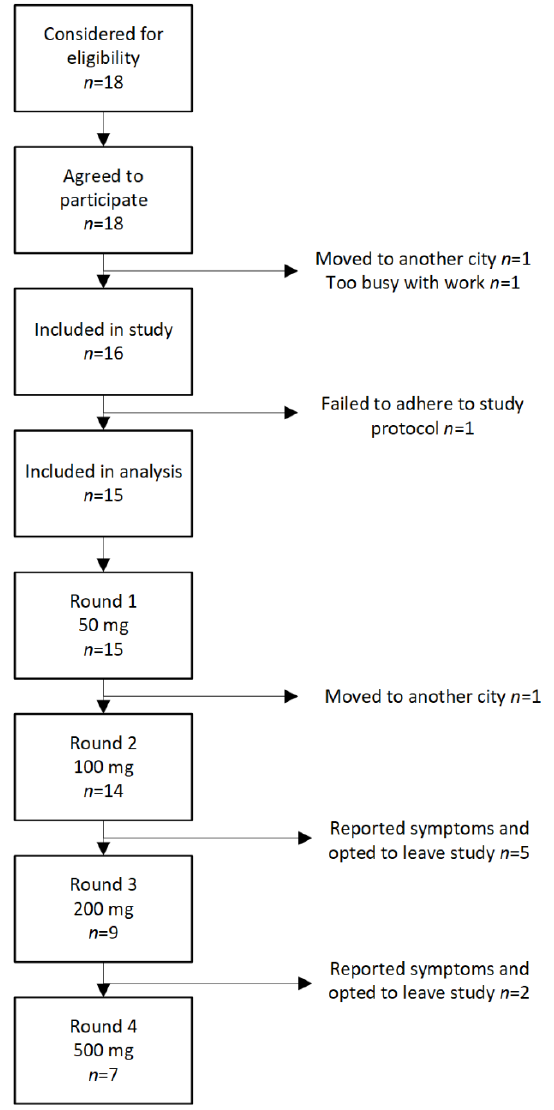
Figure 2. Flowchart of patients through the study.